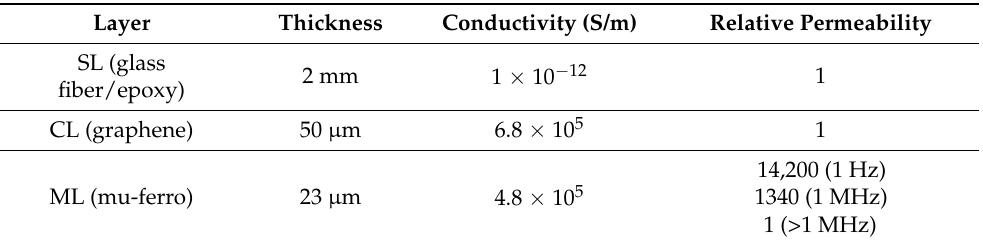
Table 1. Thickness, conductivity, and relative permeability of each layer. Layer Thickness Conductivity (S/m) Relative Permeability SL (glass